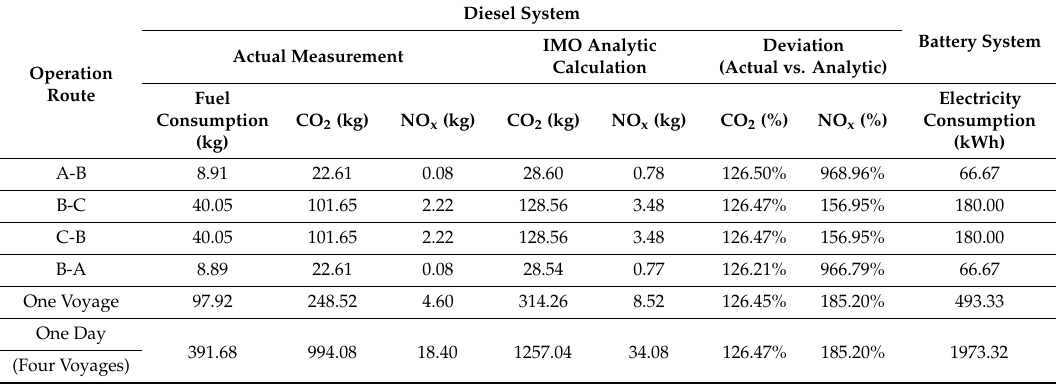
Table 6. Fuel consumption and emissions measured over various operating